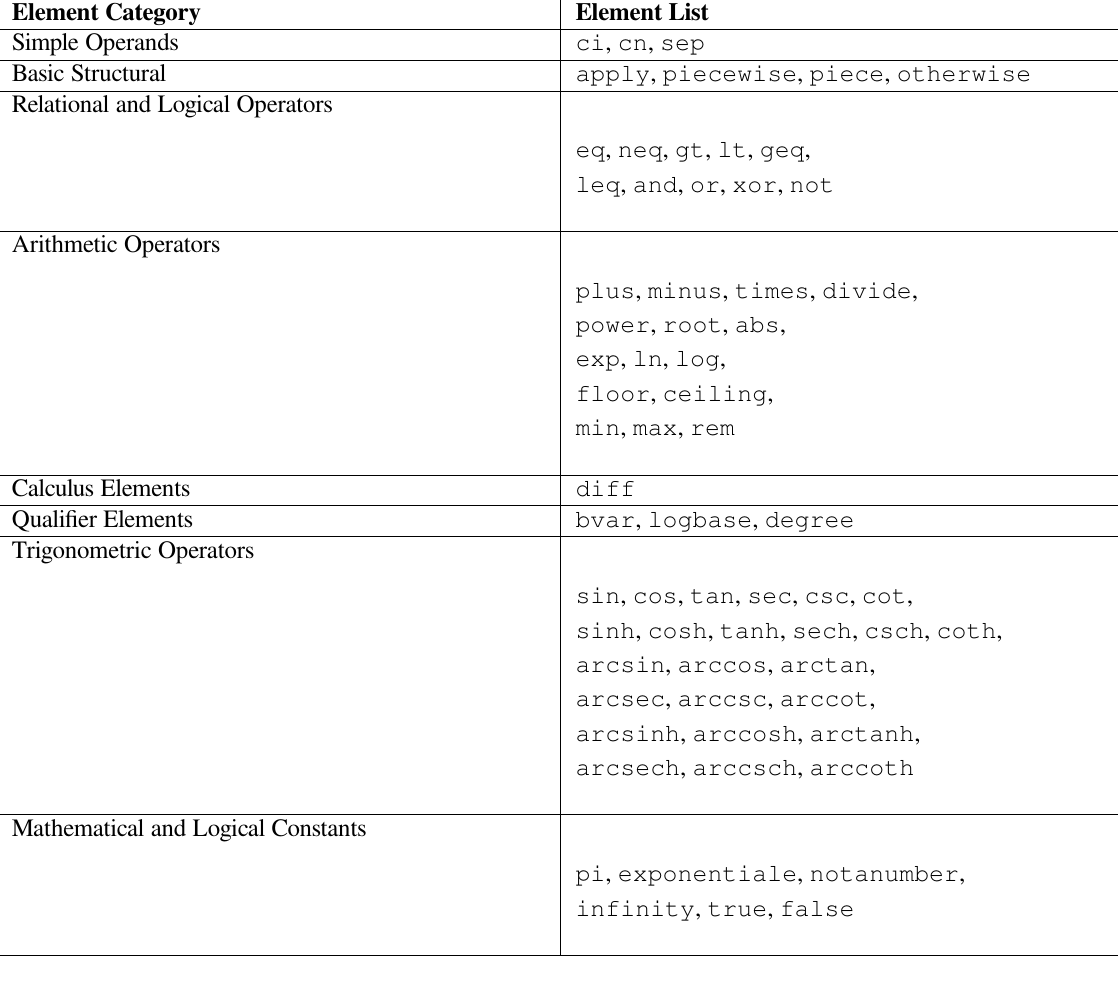
Table 2.1: Supported MathML